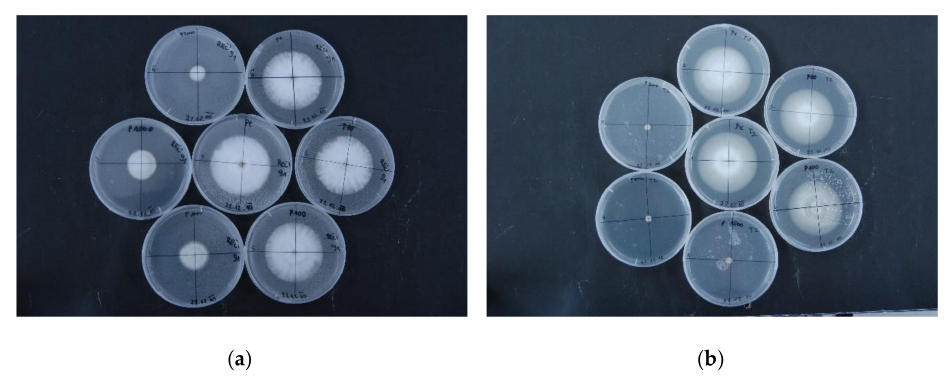
Figure 3. V. nonalfalfae growth inhibition on PDA supplemented with di ff erent concentrations of p -coumaric acid. Two isolates of V. nonalfalfae were selected for comparison: ( a ) Rec, mild pathotype M in the left panel and ( b ) T2, lethal pathotype PV1 in the right panel. Images were taken 14 days after mycelial disc inoculation on PDA plates supplemented with p -coumaric acid, dissolved in 20% methanol at six di ff erent concentrations (1, 10, 100, 1000, 1500, and 2000 ppm; depicted from top in a clockwise direction) or with solvent control (middle plate). All experiments were performed in six